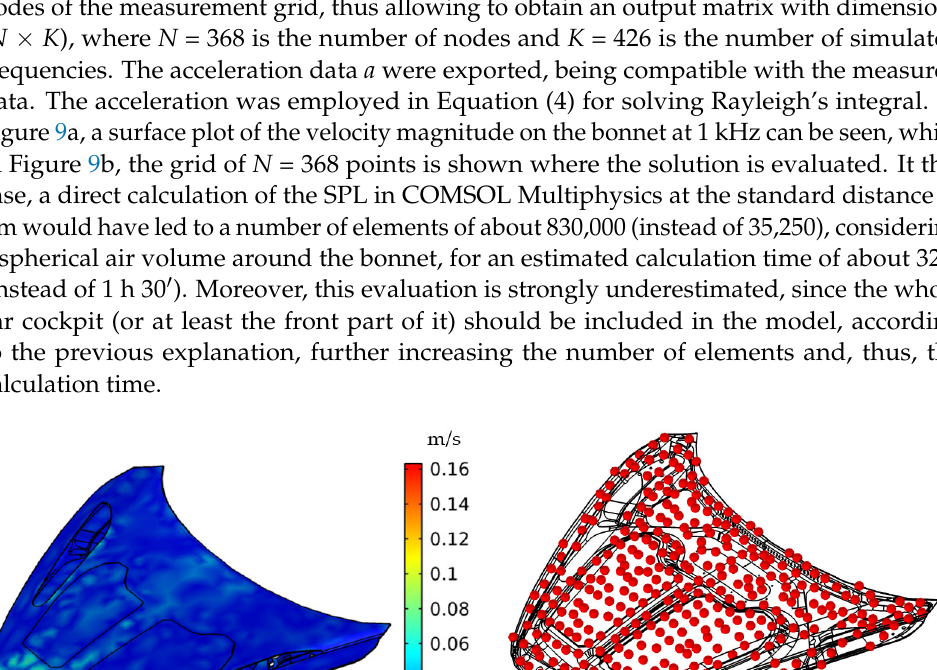
Figure 8. ( a ) View from above of the model of the car’s hood adopted for the numerical vibrational analysis. The red dot indicates the force application point. ( b ) View from below. The blue dots indicate the constraint application points.